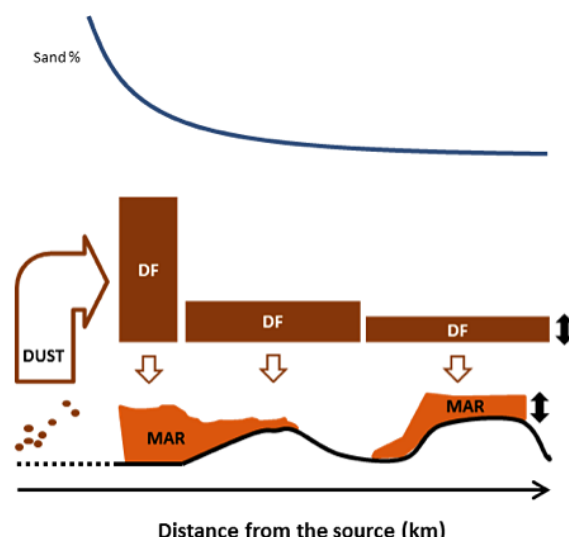
Figure 3. Conceptual plot of the evolution of dust deposition flux (DF) and size distribution (% sand) as a function of distance from the